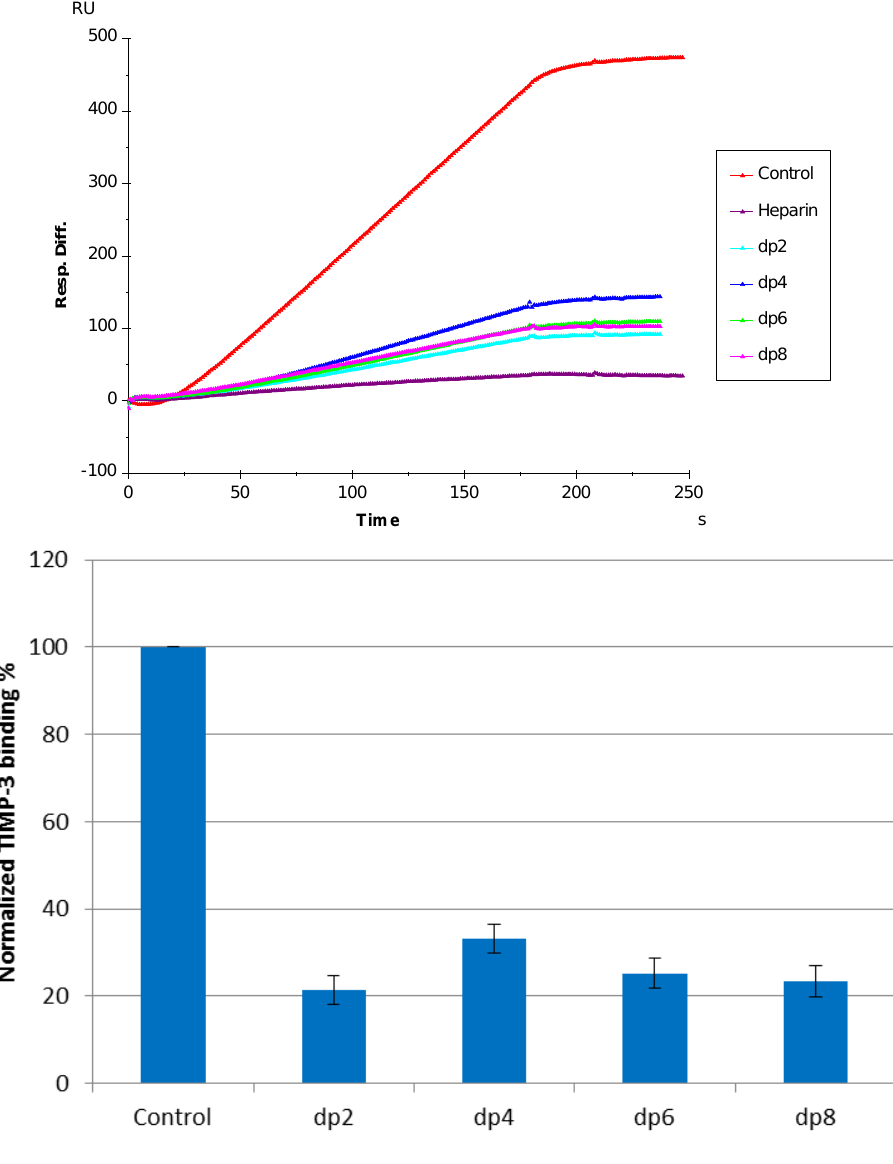
Figure 4. ( Top ): Sensorgrams of solution heparin oligosaccharides/surface heparin competition. TIMP-3 concentration was 10 nM, and concentrations of heparin oligosaccharides in solution were 1000 nM. ( Bottom ): Bar graphs (based on triplicate experiments with standard deviation) of normalized TIMP-3 binding preference to surface heparin by competing with different sizes of heparin oligosaccharides in